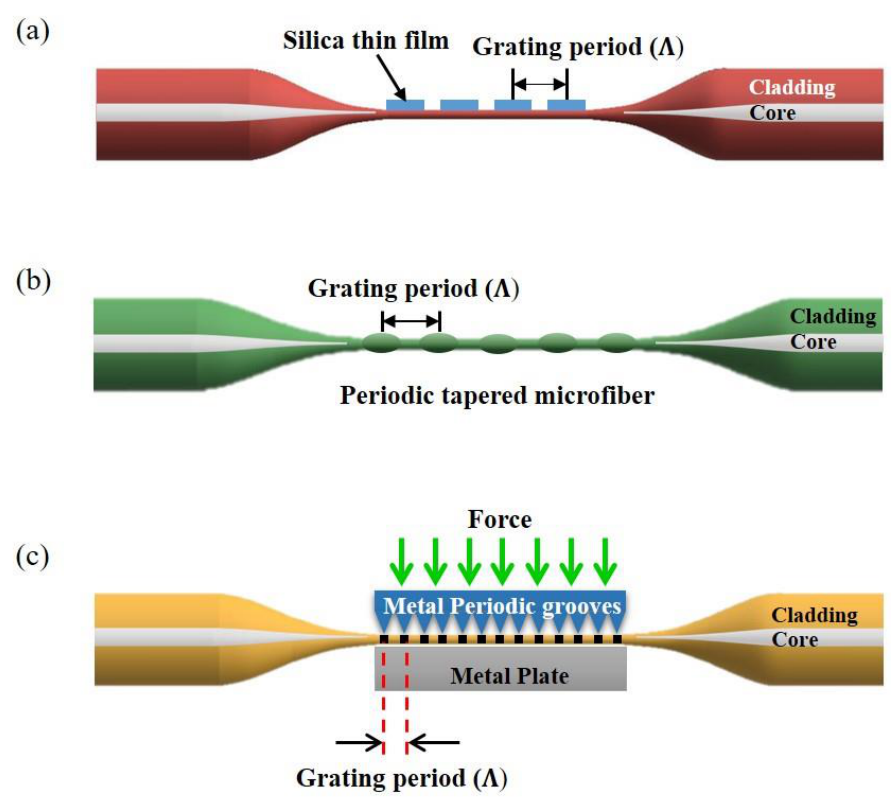
Figure 15. ( a ) Silica thin film long period grating on MF; ( b ) Schematic of MF LPG based on periodic tapered waist; ( c ) Schematic diagram of mechanical induced MF LPG.